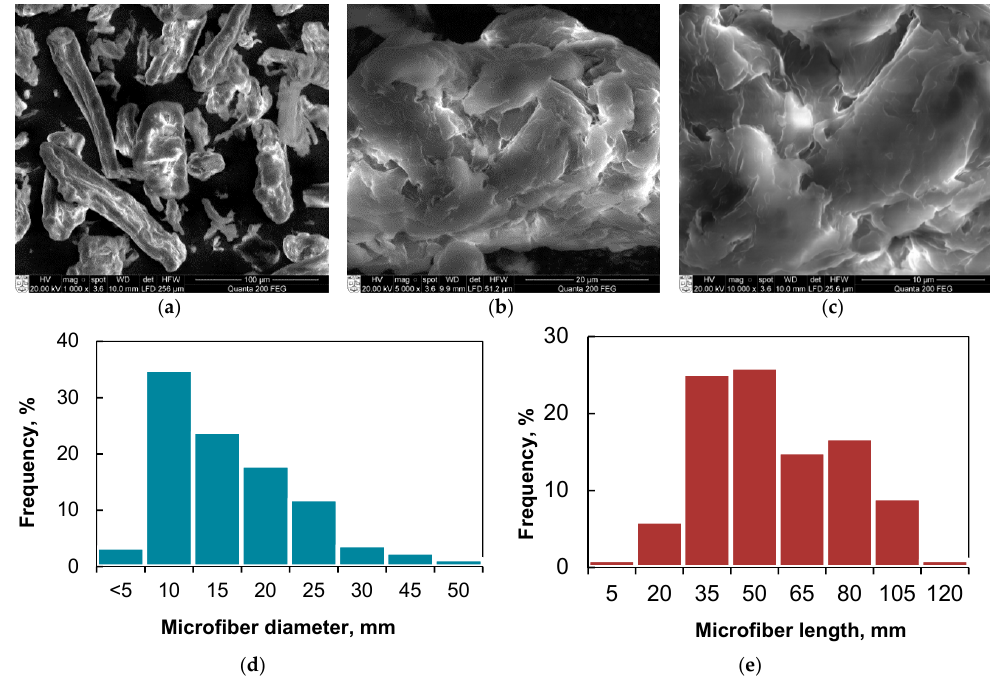
Figure 2. ( a – c ) SEM images of CFs at different magnifications; ( d ) Diameter distribution histogram. ( e ) Length distribution histogram.